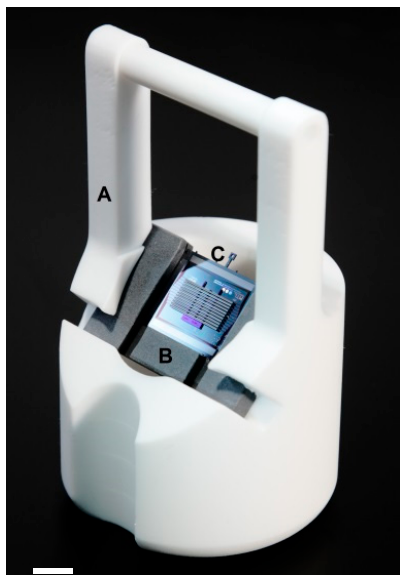
Figure 9. Teflon-based holder (A) for electroless plating. The darker insert (B) is specific to the probe (C) and holds the assembled probe at a 45-degree angle, to facilitate the removal of evolving gas from the plating sites to avoid gas getting trapped under a horizontal surface. The insert (B) can also be used to hold the probe during mechanical assembly steps (see section). The scale bar is 1 cm.